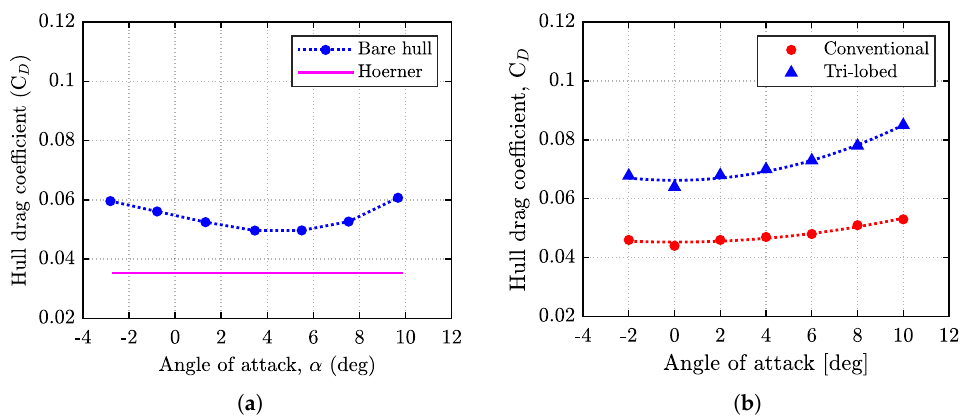
Figure 6. Bare hull drag coefficient versus angle of attack: ( a ) data taken from Carrión et al. [68]; ( b ) data obtained from CFD